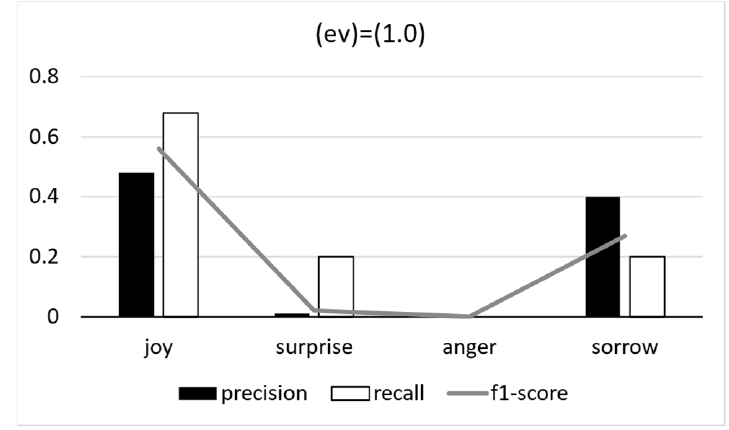
Figure 12. Evaluation results; (ev) = (1.0).